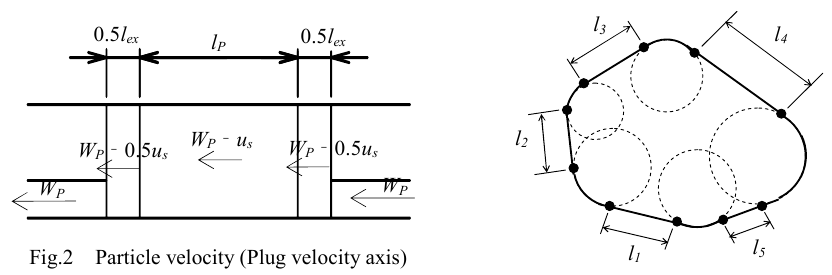
Fig.3 Ratio of straight